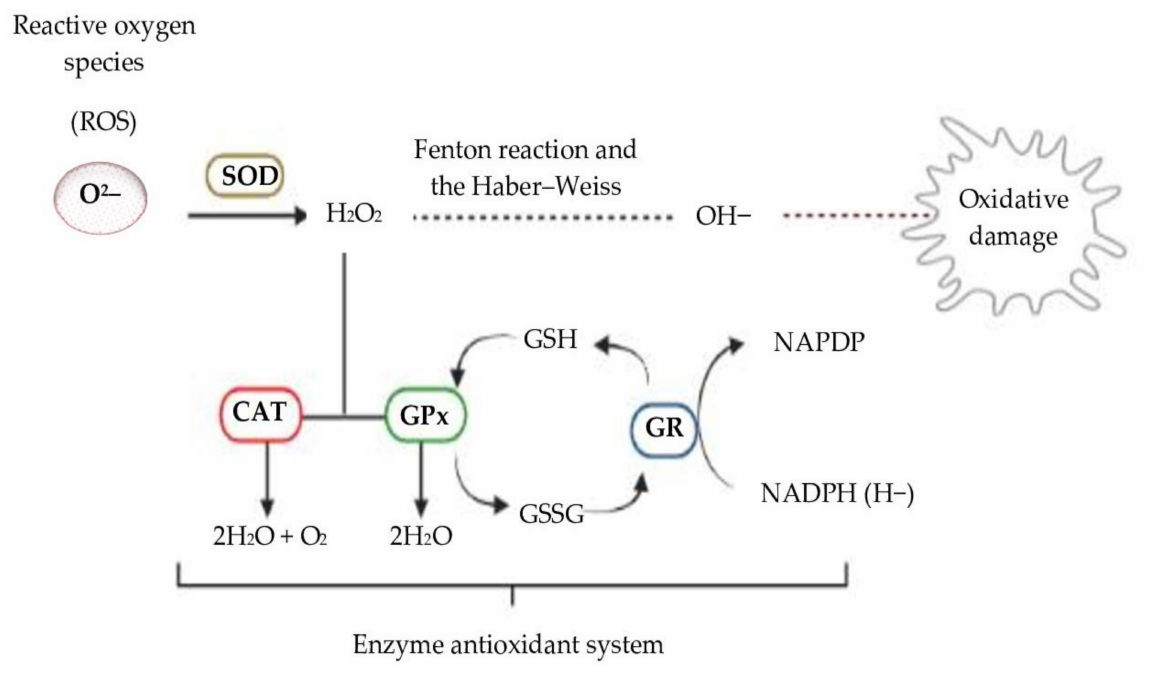
Figure 1. Integration of enzymes that participate in the antioxidant defense of the enzymatic an- tioxidant system. Note: During the processes of aerobic metabolism, reactive oxygen species are formed, such as superoxide (O 2 − ) radicals. The enzymatic system is the first to act to prevent the accumulation of these molecules and their intermediates. Superoxide dismutase (SOD) catalyzes the dismutation of the superoxide radical into hydrogen peroxide (H 2 O 2 ), which despite not be- ing a free radical, due to the absence of unpaired electrons in the last layer, H 2 O 2 is an oxygen metabolite that participates in the Fenton and Haber–Weiss reaction and results in hydrogen perox- ide (OH − )production, responsible for major cellular damage. To avoid this, other enzymes act in conjunction with SOD, namely catalase (CAT) and glutation peroxidase (GPx). CAT catalyzes the reduction of H 2 O 2 to water (H 2 O) and oxygen (O 2 ). GPx catalyzes the reduction of H 2 O 2 to H 2 O at the cost of converting reduced glutathione (GSH) to glutathione disulfide (GSSG). In the